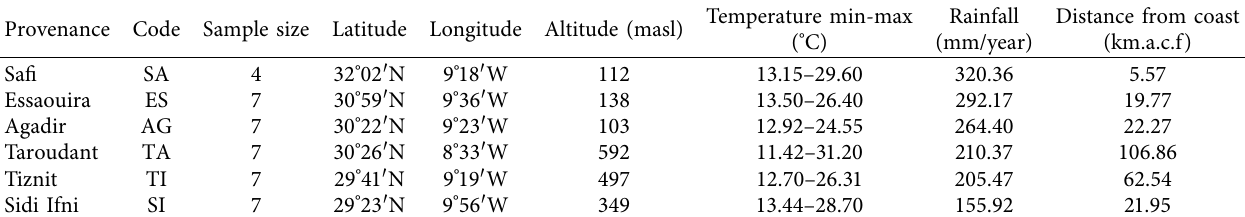
Figure 1: Altitude of sampling provenances and localisation of Argan samples. Table 1: Geographical parameters of the six sampled provenances of argan